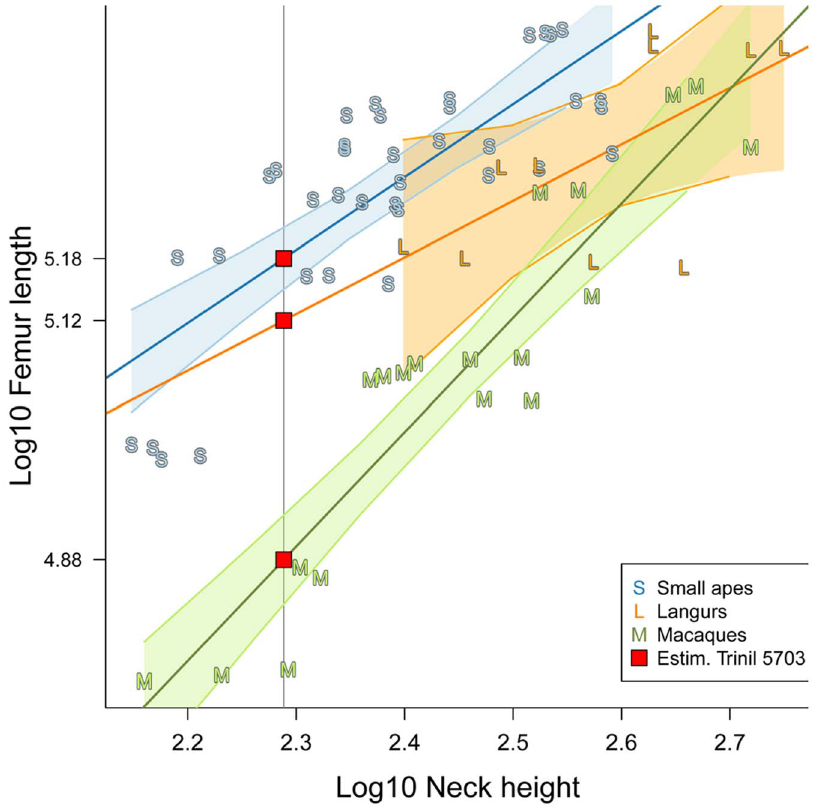
Figure 5. Linear regressions of the log-transformed total length of the femur over the log-transformed femoral neck height for each of the following clades: small apes, langurs and macaques; and estimation by each of the three different models of the original total length of Trinil 5703 (red square) from its log-transformed femoral neck height. doi:10.1371/journal.pone.0099531.g005 PLOS ONE |